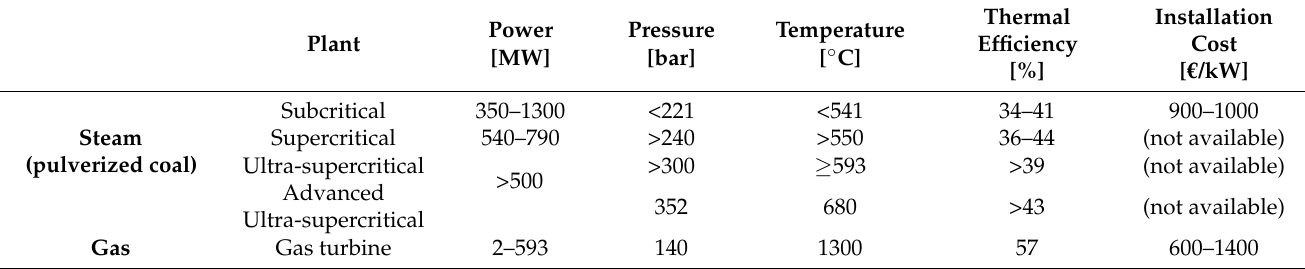
Table 1. Significative parameters of installed power (data source: [24,31,43,100,103,105]).